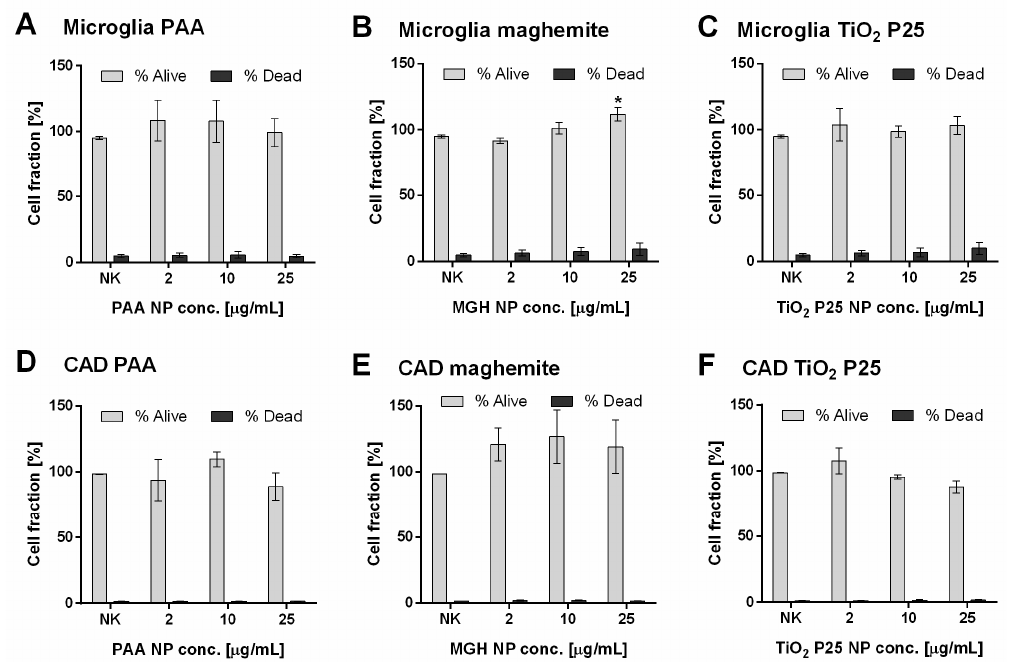
Figure 1. Viability of ( A – C ) mouse microglial cells following 24 h incubation and ( D – F ) mouse neuronal CAD cells following 48 h incubation with increasing concentration of ( A , D ) biomedical polyacrylic acid (PAA) coated cobalt ferrite NPs, ( B , E ) uncoated maghemite (MGH) NPs and ( C , F ) industrial TiO 2 P25 NPs. Viability was determined with Hoechst/PI differential staining. Mean and standard error are shown for three independent experiments performed in duplicates. Statistical significance is displayed as: ns ( p > 0.05); * p ≤ 0.05.